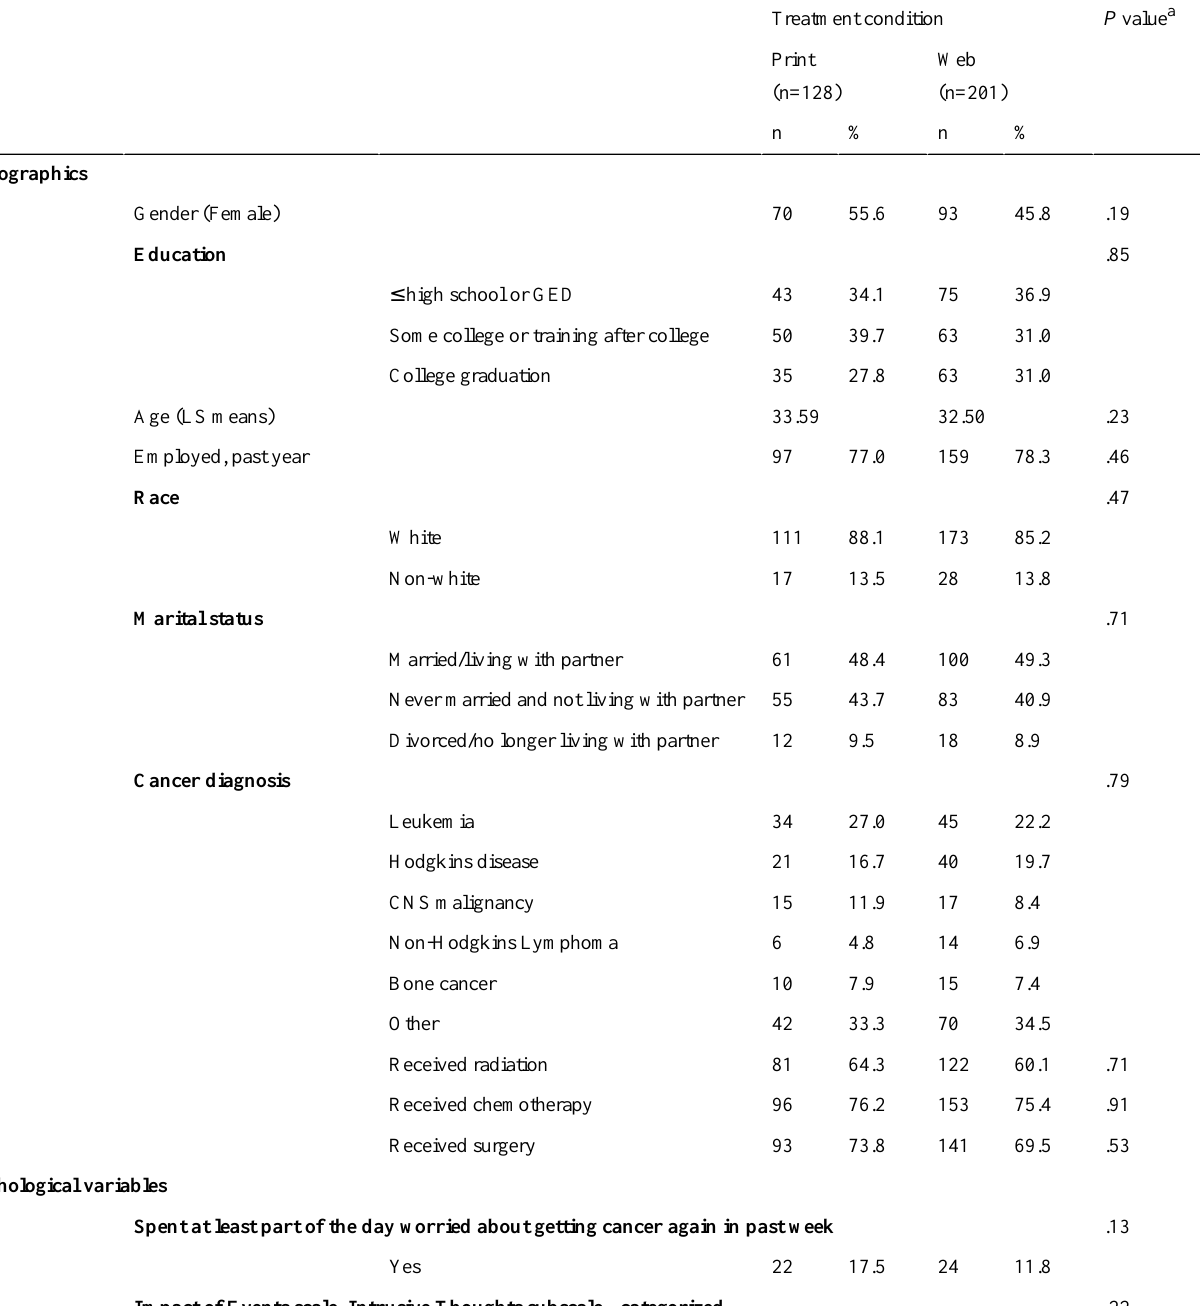
Table 1. Baseline variables by treatment condition